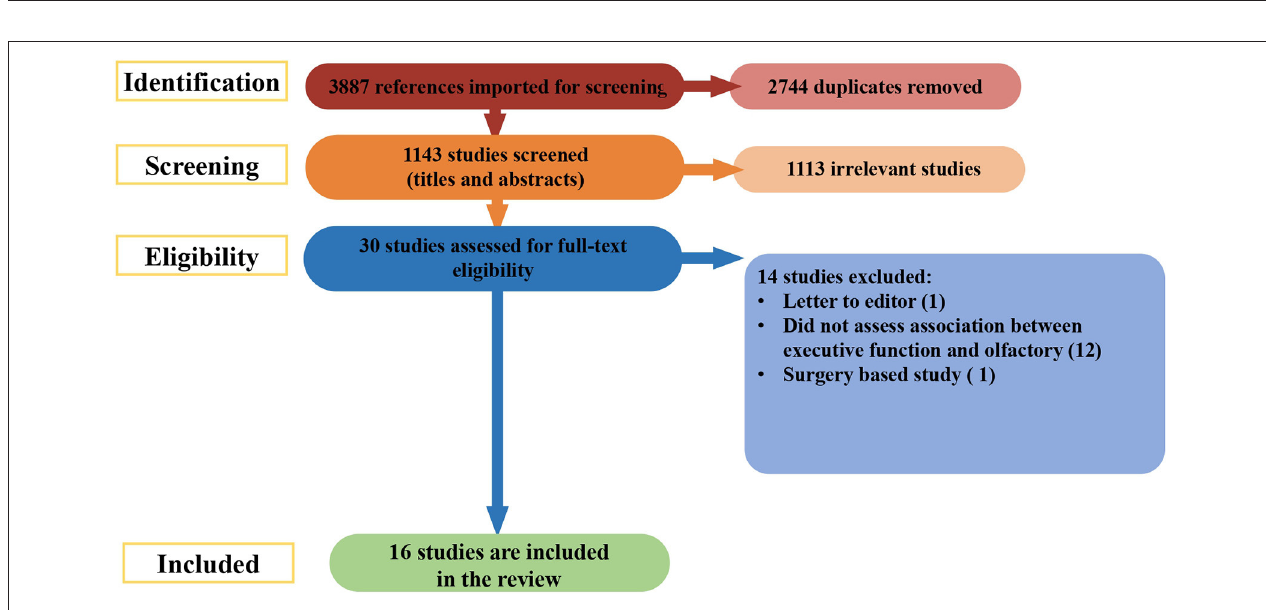
FIGURE 2 | Prisma flow